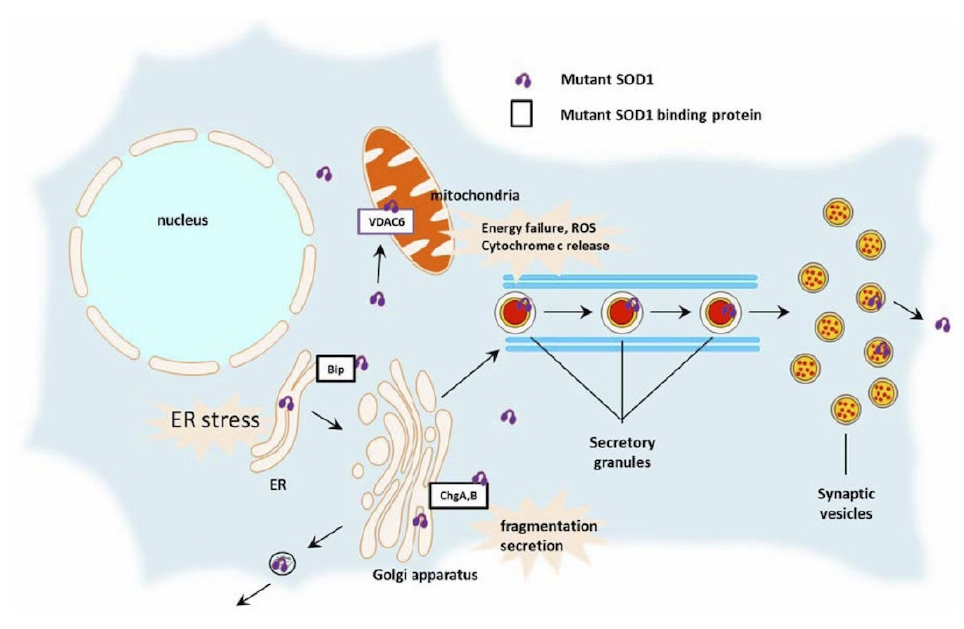
Figure 2. Aberrant subcellular localization of mutant SOD1 protein and its effect on amyotrophic lateral sclerosis (ALS) pathogenesis: mutant SOD1 interacts with several binding proteins ( i.e. , endoplasmic reticulum chaperone protein GRP78/Bip, voltage-dependent anion channel 6 or VDCA6, and chromogranin A or ChgA and B or ChgB), resulting in cell death when abnormally redistributed (Source: Ido et al.